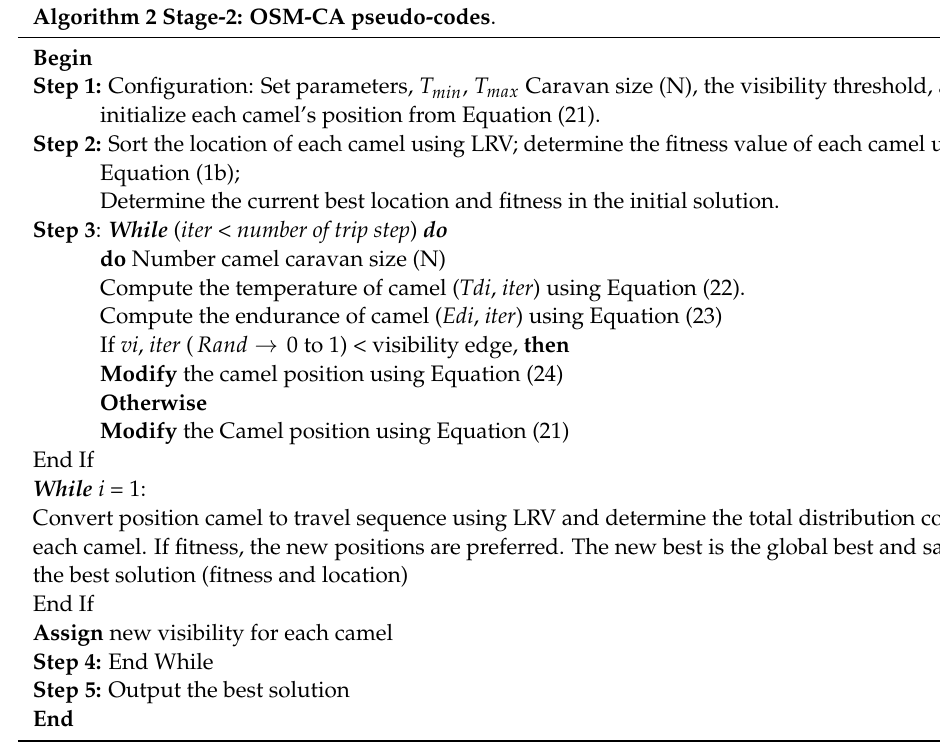
Algorithm 2 Stage-2: OSM-CA pseudo-codes